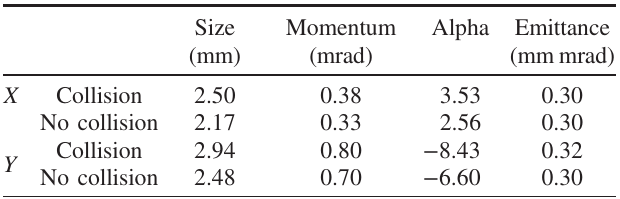
TABLE III. Transverse Twiss parameters at the end of linac with and without collisions.